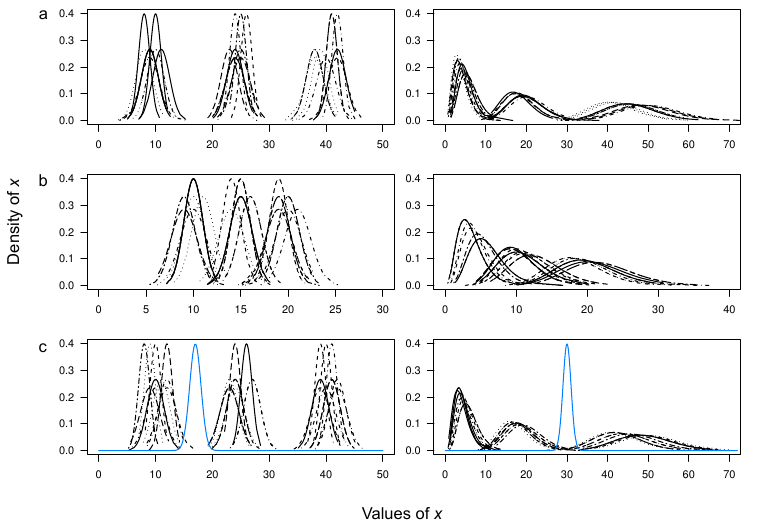
Figure 4. Illustration of some assessed simulation schemes where three clusters of n = 30 curves with a ( a ) separated, ( b ) overlapped, and ( c ) atypical structure are generated. Clusters of Normal ( µ , σ 2 ) and Gamma ( α , β ) distributions are presented in the first and second columns, respectively. In ( c ), atypical curves are shown in